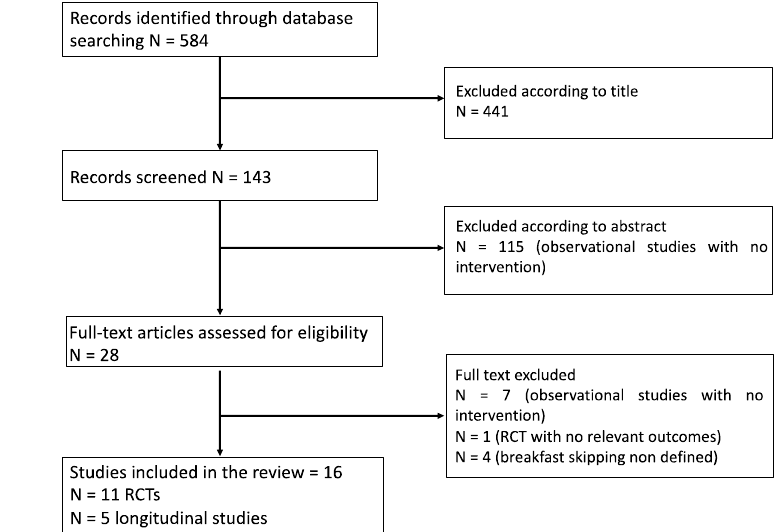
Figure 1. Flowchart of study selection.